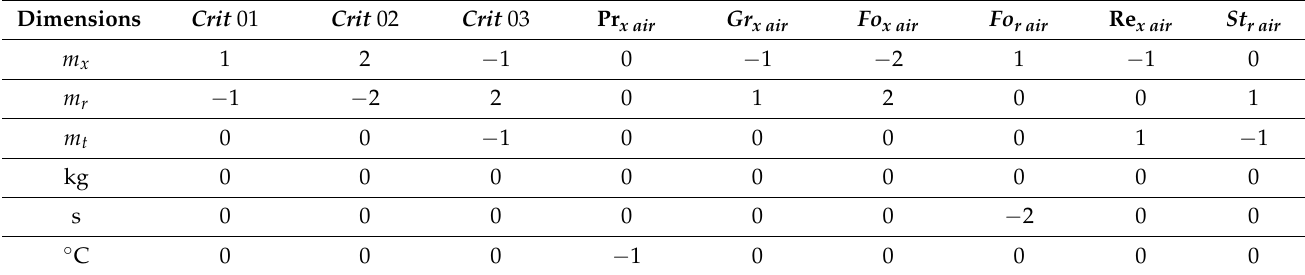
Table 10. The quantities required by the heat transfer correlations between dimensionless numbers (part of matrix B).